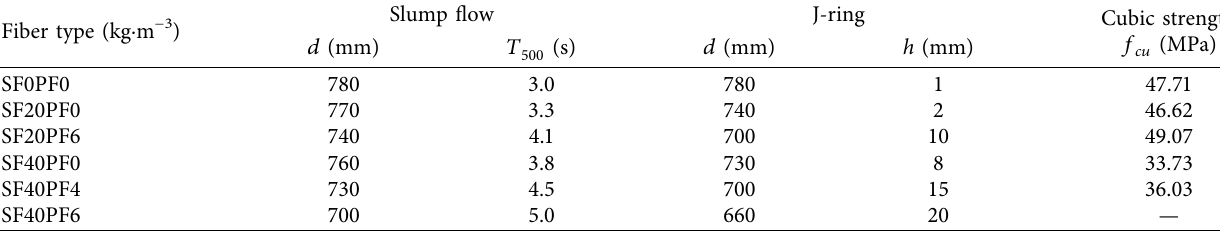
Table 3: Test results of workability and cubic